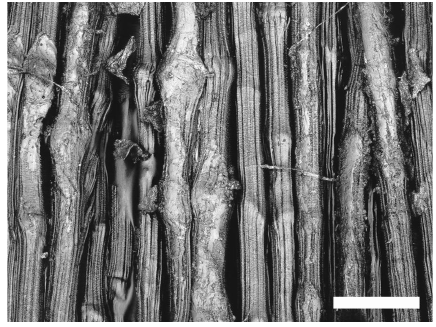
Figure 1. Images of treated UHMW PE fiber; bar = 50 µ m.